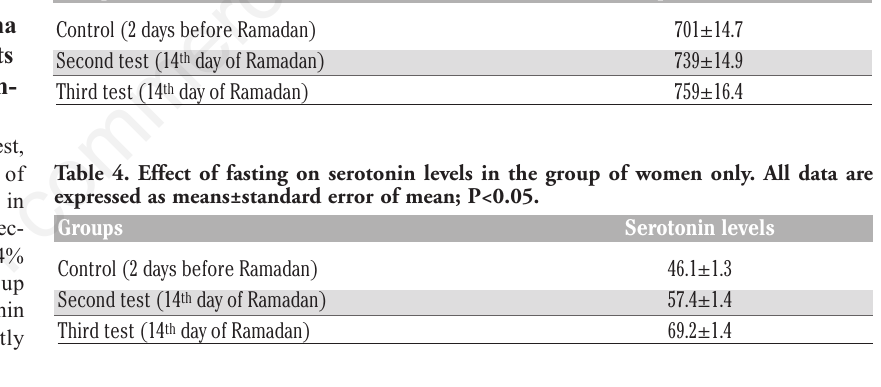
Table 3. Effect of fasting on dopamine levels in the group of women only. All data are expressed as means±standard error of mean; P<0.05. Groups